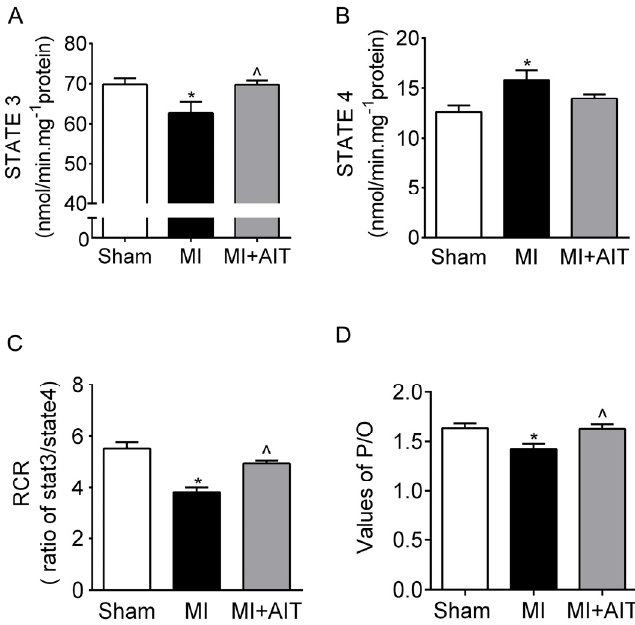
Figure 3. Effects of MI and AIT on mitochondrial respiratory function. After 8 weeks, the rats were killed, and mitochondrial respiration functions were evaluated. ( A ) State 3 of cardiac mitochondrial respiration; ( B ) State 4 of cardiac mitochondrial respiration; ( C ) Cardiac mitochondrial respiratory control ratio (RCR = State 3/State 4); and ( D ) P/O ratio for